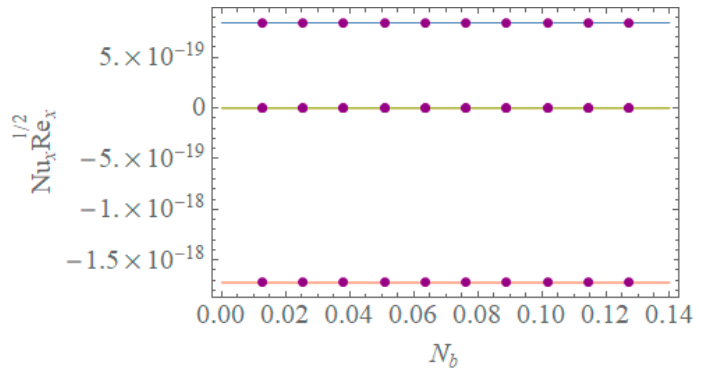
Figure 14. Assessment of TLM-BANN for f with reference dataset of TD-PNFM. Variation of N t for Nu x Re − 1/2 x